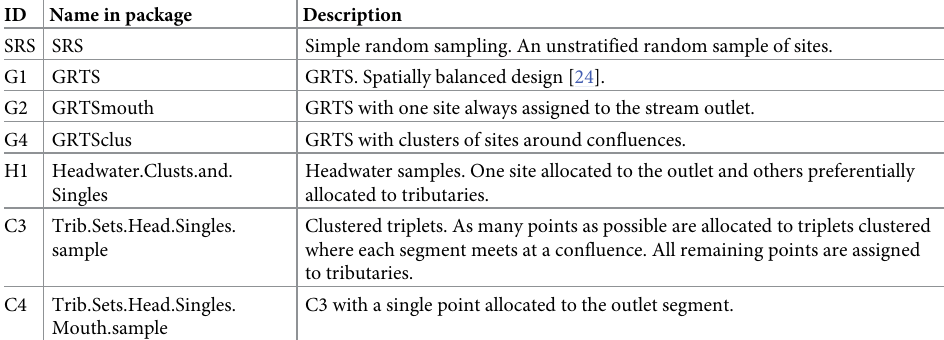
Table 2. Standard designs from Som et al. [15]. Note that ‘name in package’ is the string argument that must be passed to the drawStreamNetworkSamples function to use the sampling